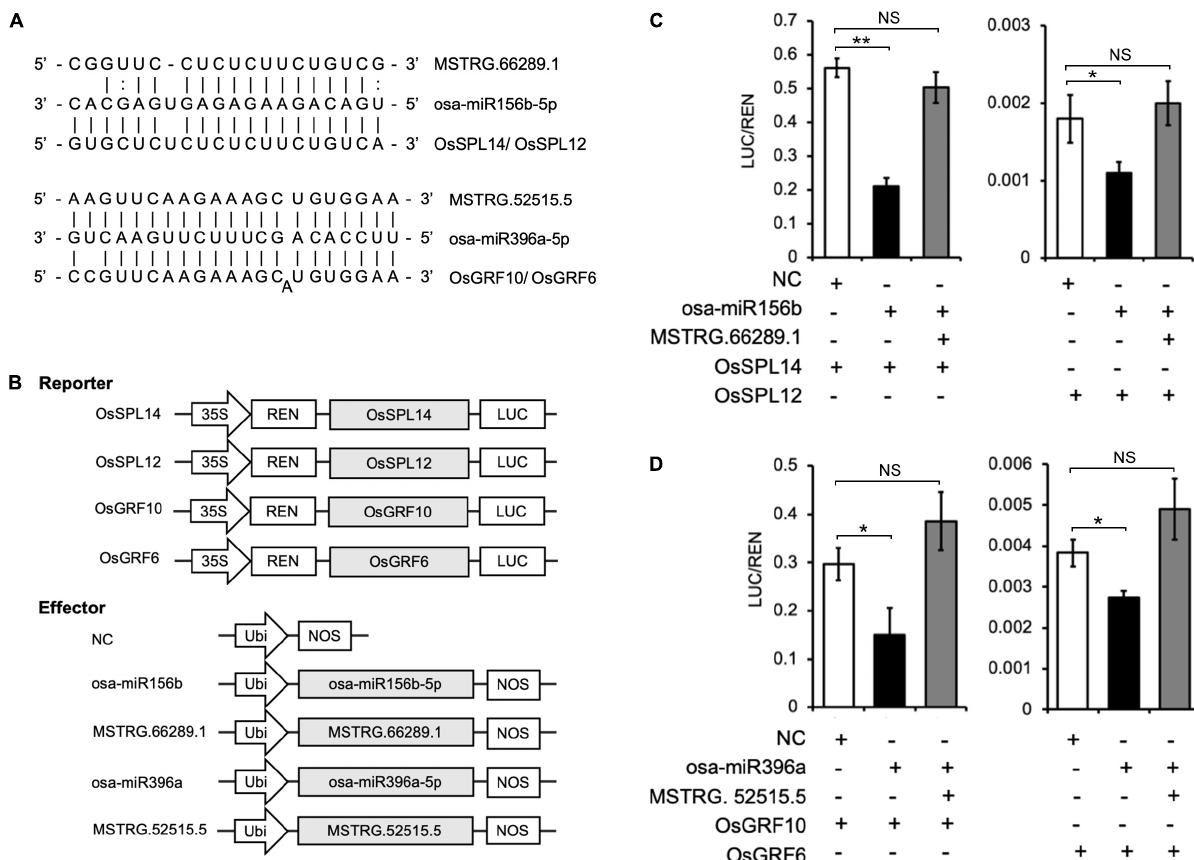
FIGURE 9 | Dual luciferase reporter assay validation of two lncRNAs MSTRG.66289.1 and MSTRG.52515.5 acting as eTMs for osa-miRNA156 and osa-miRNA 396 to regulate SPL and GRF genes expression, respectively. (A) Predictive interaction sites among lncRNAs, miRNAs and the corresponding target genes. (B) Schematic diagram of the dual luciferase reporter and effector vector constructs. The coding sequences of OsSPL14 , OsSPL12 , OsGRF10, and OsGRF6 were cloned into the reporter vector pGreenII 0800-LUC. The precursors of osa-miR156b-5p and osa-miR396a-5p, as well as the complete sequences of MSTRG.66289.1 and MSTRG.52515.5 were cloned into the effector vector pCXUN. LUC, firefly luciferase gene; REN, Renilla luciferase gene; and NC, negative control. (C,D) Dual luciferase reporter assay. The dual luciferase reporter vectors containing OsSPL14 , OsSPL12 , OsGRF10, or OsGRF6 were co-transfected into rice protoplasts together with effector vectors containing the osa-miR156b-5p or osa-miR396a-5p precursors or with effector vectors containing the eTMs MSTRG.66289.1 or MSTRG.52515.5, as indicated in each assay. After 20 h, the luciferase activities were measured using the Dual Luciferase Reporter Gene Assay Kit. Error bars indicate the mean ± SD ( n = 3). NS, no significant difference detected; * p < 0.05, ** p <